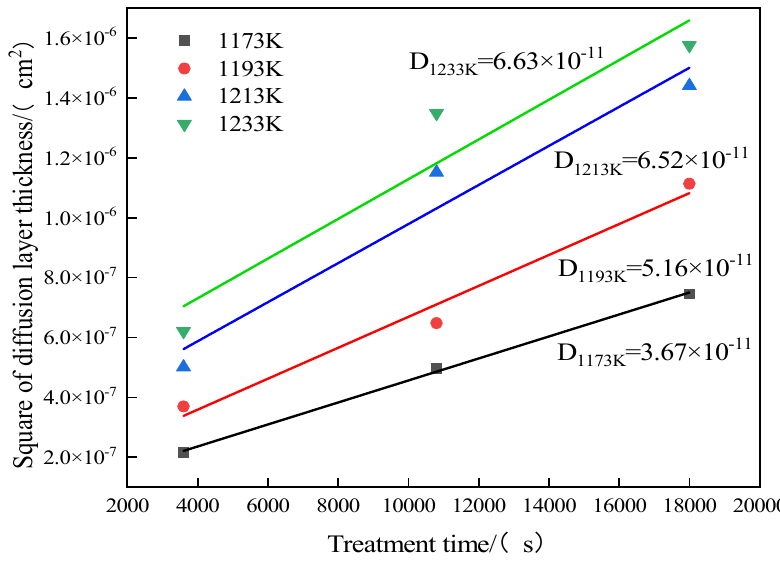
Figure 11. Square of vanadiumizing layer thickness versus duration at different temperatures.